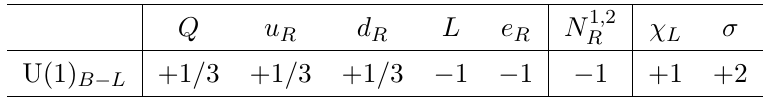
Table 4 . B − L charges of the particles in Model C2. Q and L are the SM quark and lepton SU(2) L doublets; u , d and e are the SM fermion singlets. N 1 , 2 R R R candidate, and σ is a complex